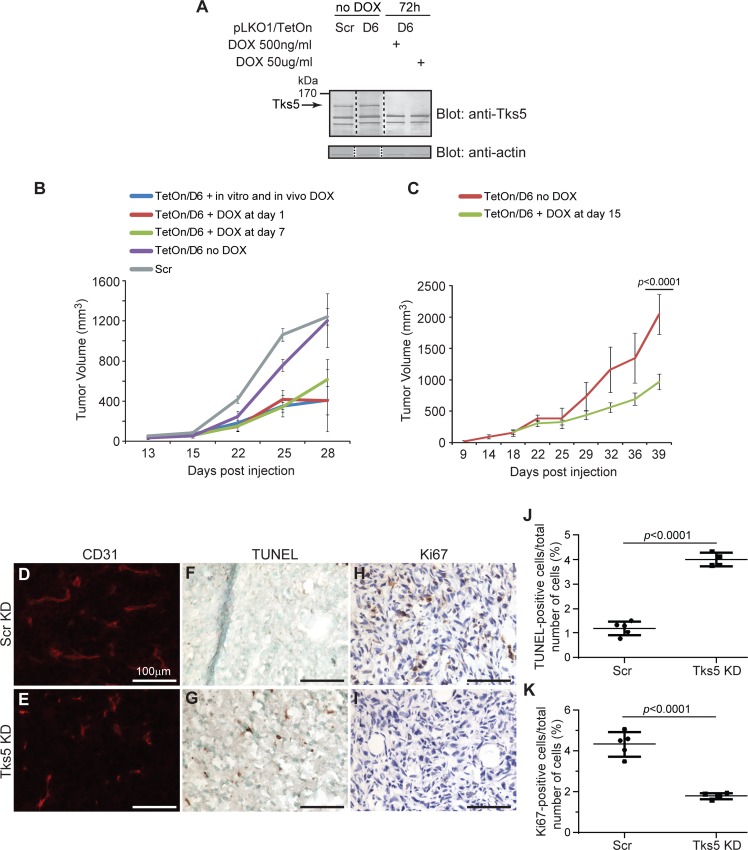
Tks5 is required for tumor progression.MDA-MB-231-Luc cells were infected to stably express an inducible TetOn lentivirus where the levels of the Tks5 shRNA are under the control of the tetracycline promoter (see Materials and methods for the experimental procedure). A) Immunoblot demonstrating Tks5 expression reduction in the MDA-MB-231-Luc cell line in dose- and time-dependent fashion in response to doxycycline exposure. B) TetOn/D6 were injected orthotopically (blue, red, and green lines) compared to SCR and no doxycycline controls (grey and purple lines, respectively) under three conditions: when Tks5 was already reduced by in vitro exposure of the cells to doxycycline for 10 days (DOX A) (blue line), when unexposed cells were injected into the animal and the animal received doxycycline starting at the day of injection (DOX B) (red line), as well as when the animals received doxycycline in the drinking water for the first time after the tumor has been growing for 7 days (DOX C) (green line). C) Animals were given doxycycline 15 days after tumor cell injection and after randomization of the mice. TetOn/D6 mice were divided up in 3 groups where 2 groups received doxycycline in the drinking water at different time points and 1 group received doxycycline-free drinking water. Tumor volumes were measured at different time points as described in Materials and methods, and tumors were allowed to grow to a final volume of approximately 2cm3. N = 4 mice per tumor type. Experiments were performed in duplicate. D-I) Tumors from Fig 4C were analyzed for vascularization by CD31 (panel D-E), for apoptosis by TUNEL (panel F-G) and for proliferation using Ki-67 (panel H-I) immunofluorescence staining. Scale bar: 100μm. Images are representative for all experiments performed. J-K) Quantification of positive immunohistochemical and immunofluorescence staining. Graphs show immunopositive cells for apoptosis (TUNEL) (panel J) and proliferative (Ki67) (panel K) markers at the day of dissection (endpoint of experiment). Data were expressed as mean ± SD. One-way ANOVA or a Student’s t test was used to calculate p values.